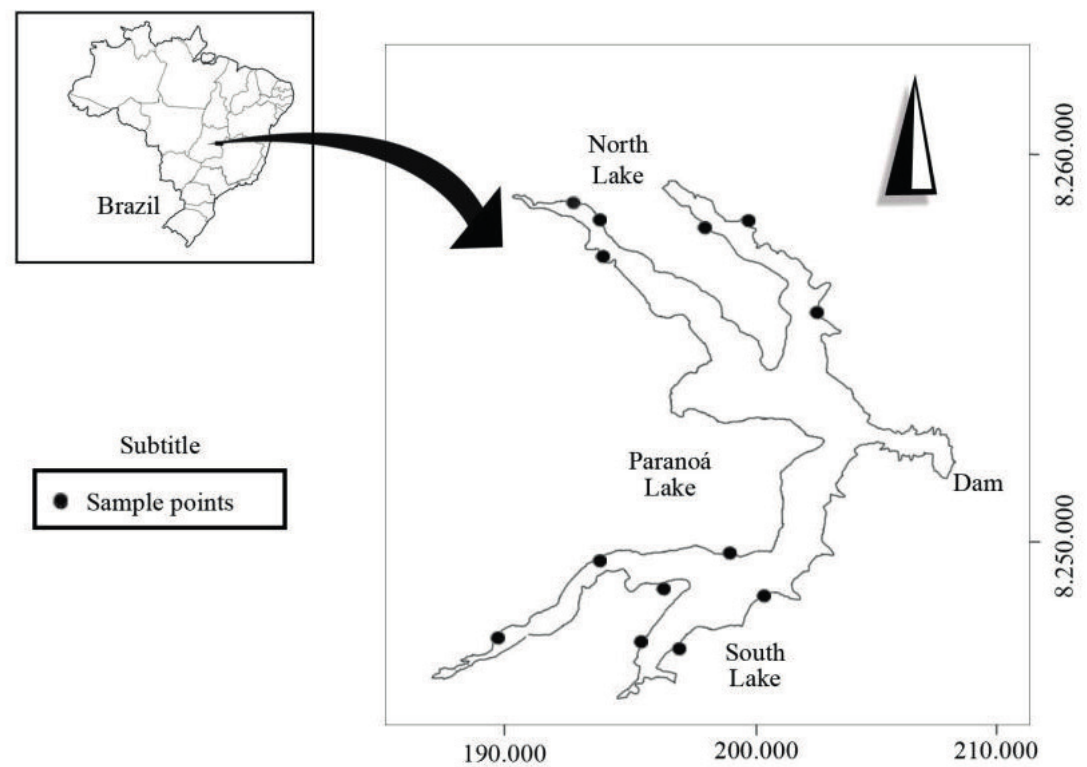
Figure 1. Lake Paranoá, Federal District, Brazil. Black circles correspond to the sampling